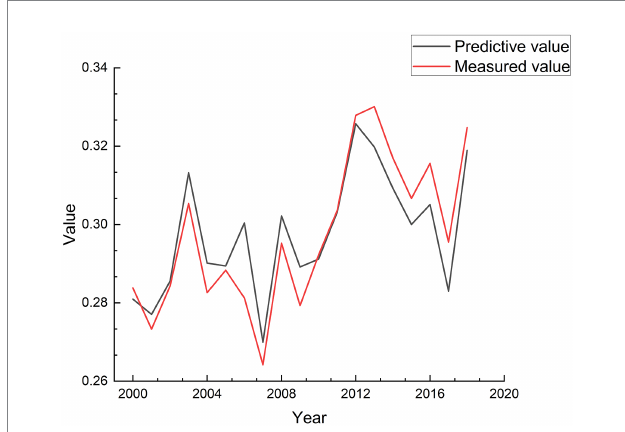
FIGURE 6 Comparison of predicted and measured NDVI values for grasslands on the Mongolian Plateau from 2000 to 2018.